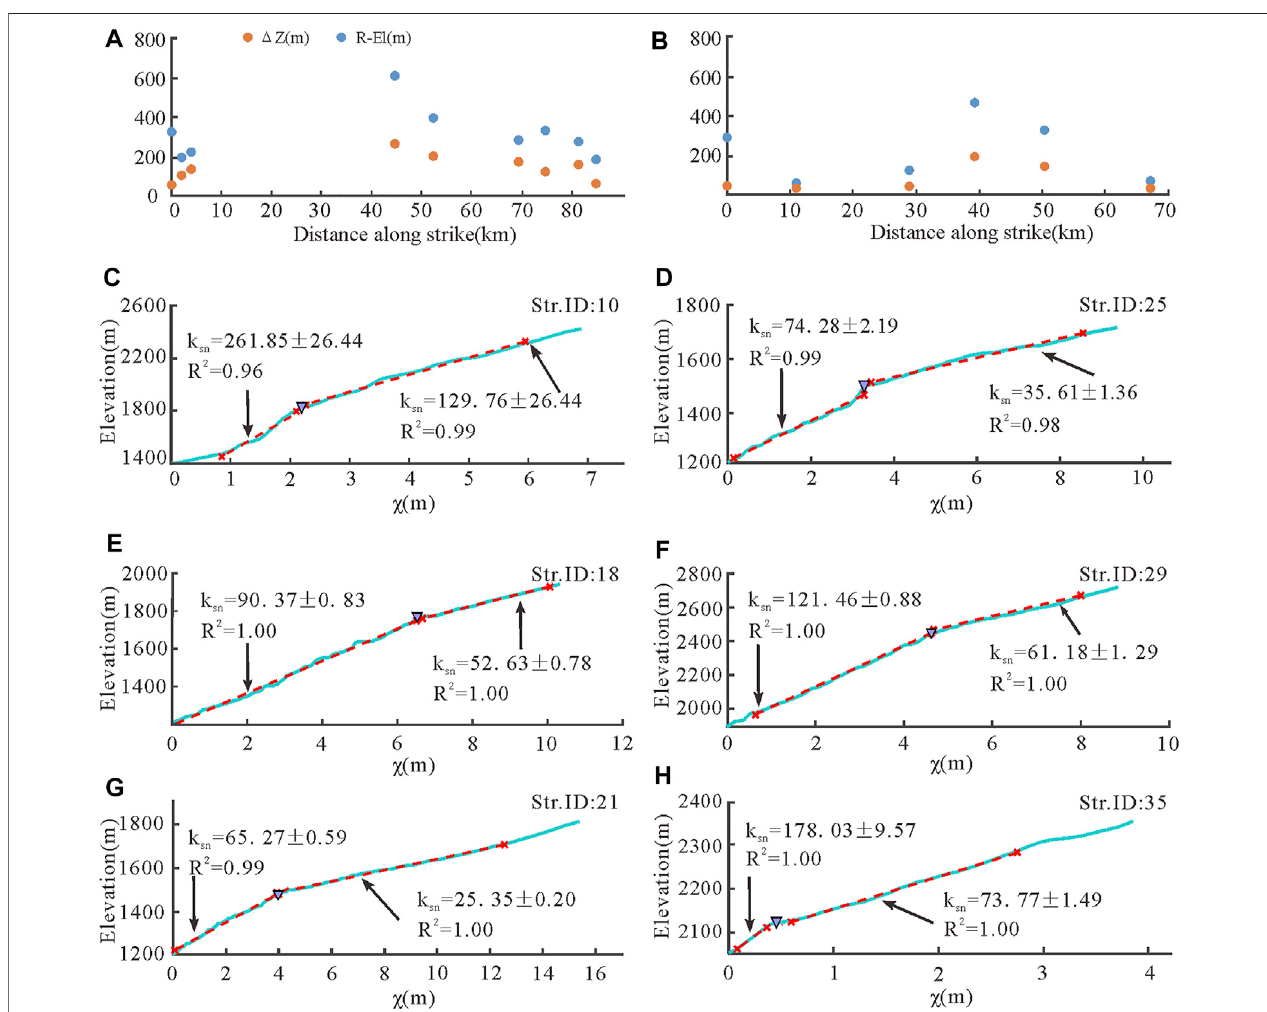
FIGURE6|(A – B) Δ ZandR – Elalongthedirectionofthescatterpointdistributionmap.R – Elindicatestherelativeknickpointelevation.Theabscissarepresentsthe projection distance of the streams along strike from the southernmost stream to the northernmost stream. Here, A represents the eastern Helan Shan, using stream 10 as the starting point; B represents the western Helan Shan, using stream 40 as the starting point. (C – H) Analysis results of the fl uvial longitudinal pro fi les. Typical river longitudinalpro fi lesindifferentpartsofthestudyareaareshowninthe fi gure.TheStr.IDisthestreamnumbershownin Figure4A .Bluelinesindicatetheoriginal χ - zpro fi les,red-dashedlinesindicatetheregressed χ -zpro fi les,andtheredcrossrepresentsthestartandendofthe fi tting.Abruptchangesintheslopewereclassi fi edas knickpoints denoted by dark blue